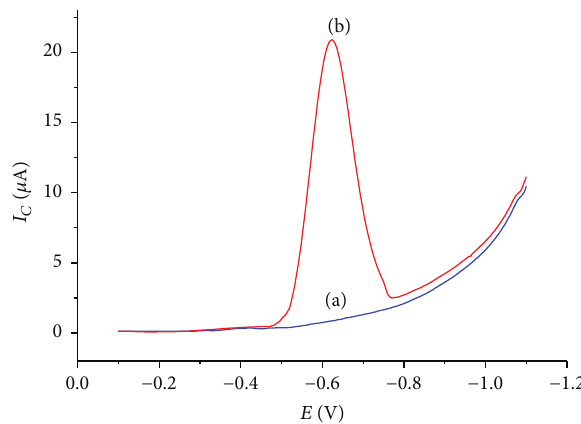
Figure 5: Square wave voltammograms of CPE in pH 7.0 BRB solution containing (a) no MTZ and (b) 1mM MTZ.